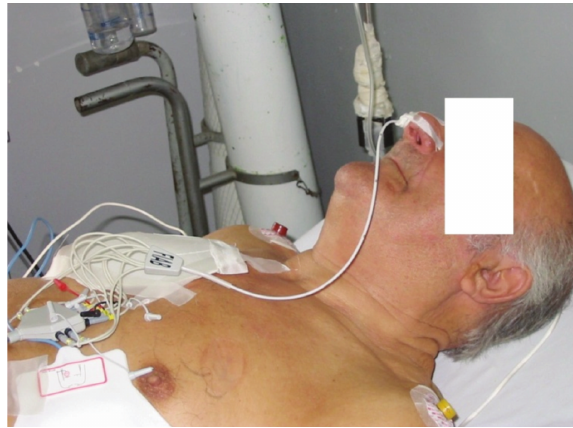
Figure 2: Esophageal-precordial